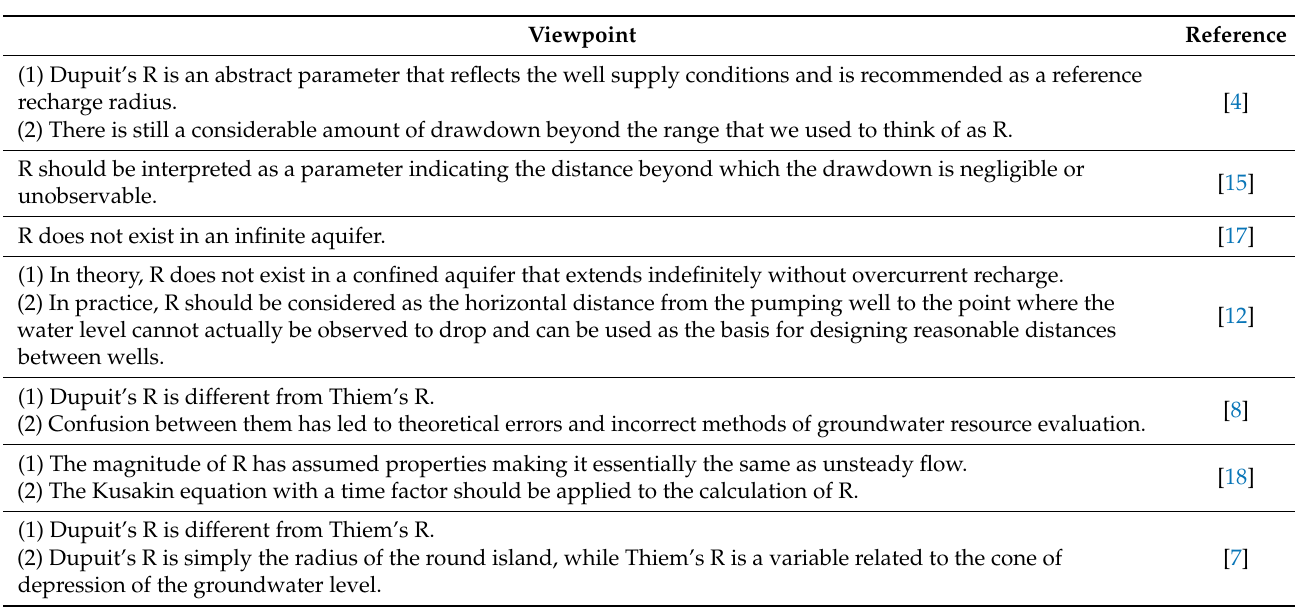
Table 4. Some representative viewpoints on the influence radius (R).